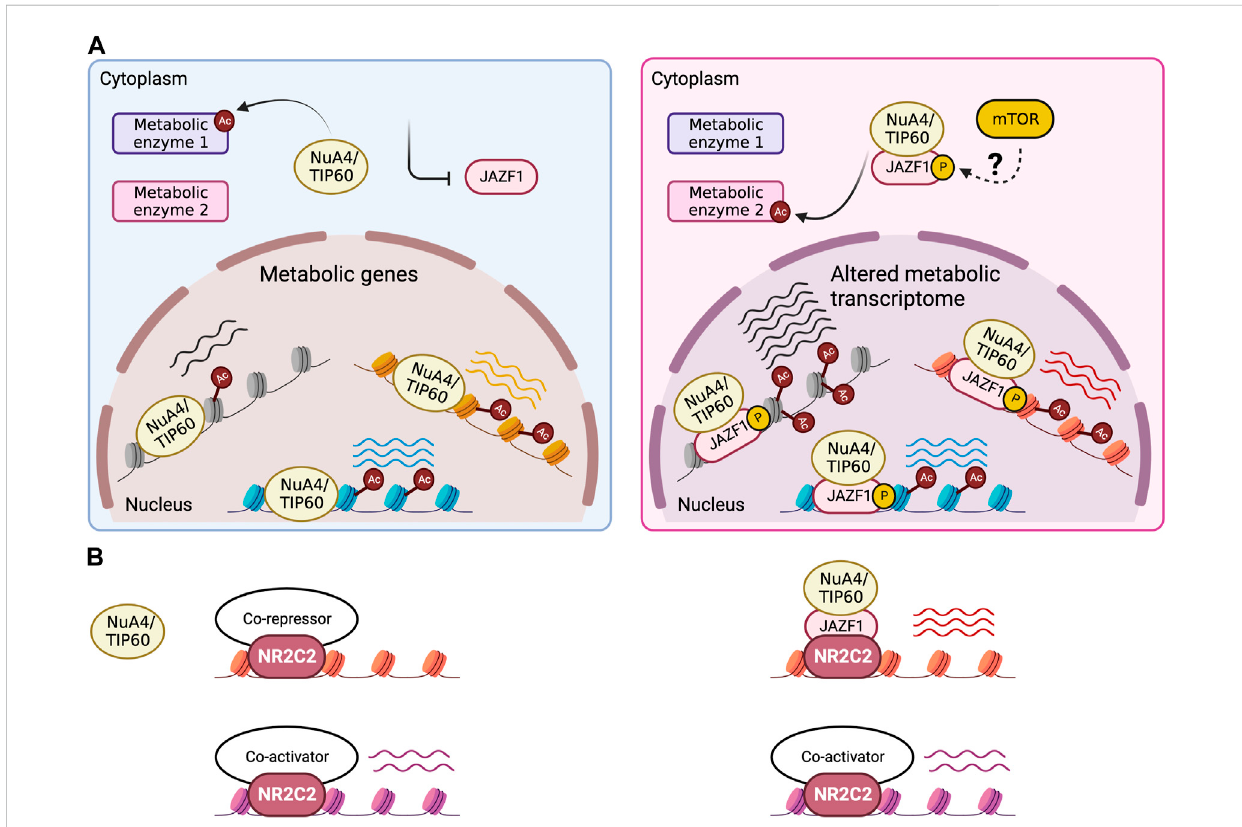
FIGURE 2 JAZF1 fi ne-tunes metabolic activity of the NuA4/TIP60 complex. Hypothetical model for the role of JAZF1 within the NuA4/TIP60 complex. (A) Enzymatic activity and speci fi city of the NuA4/TIP60 complex, either on chromatin at metabolic genes or towards metabolic enzymes, may be sensitive to the presence or absence of JAZF1 in the complex, which in turn could be controlled by expression, subcellular localization, or context-dependent assembly into the complex. Based on homology with Sfp1, mTOR-mediated phosphorylation may be involved in the process. (B) JAZF1 is possibly required for NR2C2-dependent recruitment of the NuA4/TIP60 complex at speci fi c gene